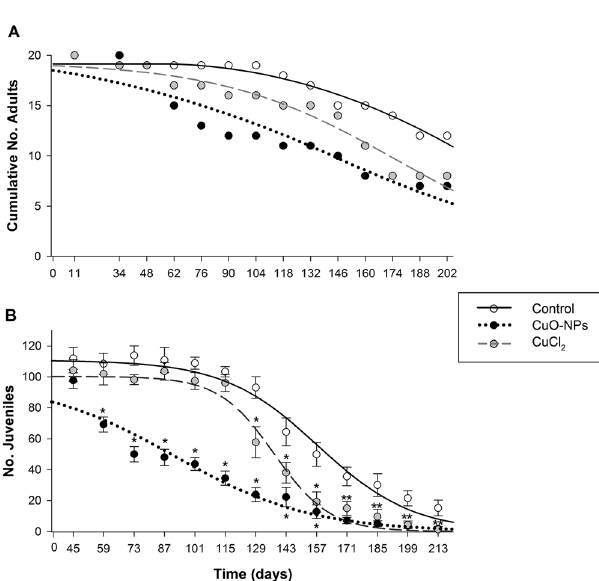
Table 1. Summary of the Effect Time (ETx) for survival (LTx) and reproduction for Enchytraeus crypticus in control conditions in LUFA 2.2 soil at two different organisms’ densities (1 organism (D1) and 20 organisms (D20)). 95% Confidence Intervals (CI) are shown in brackets.